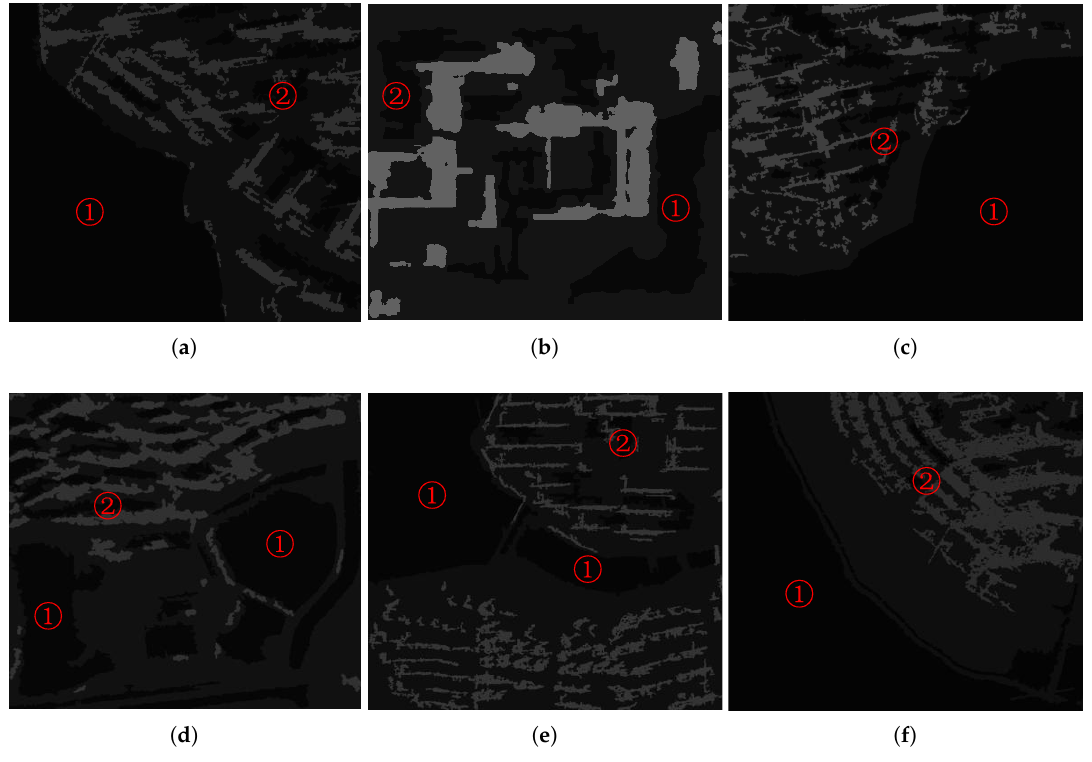
Figure 4. Segmentation results of GF-3 images ( 1 (cid:13) represents water; 2 (cid:13) represents building